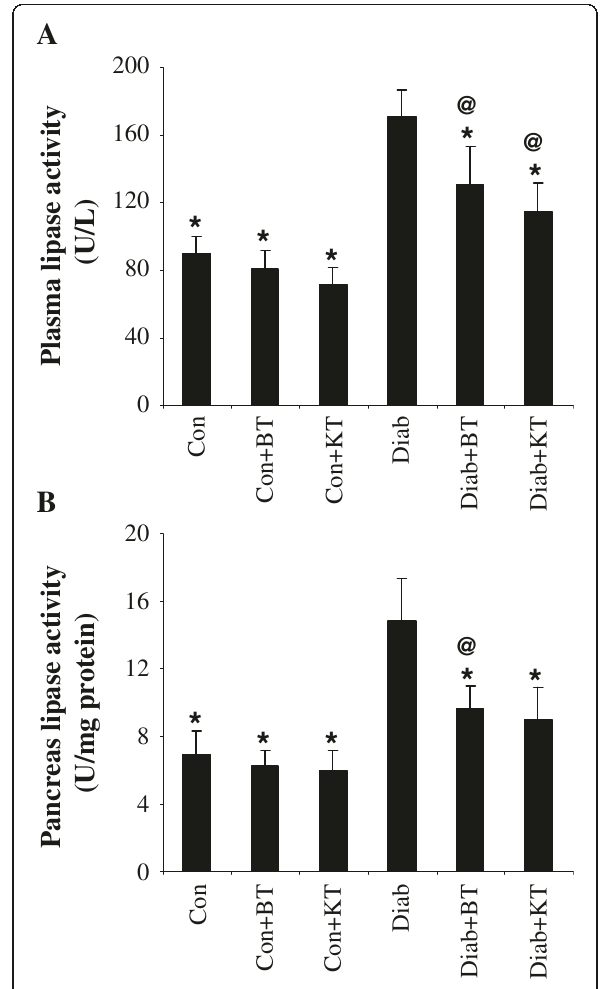
Figure 3 Effect of KT and BT on lipase activity in plasma (A) and pancreas (B) of surviving diabetic rats. Data represent mean±S.D (n=8 for each group). The values are statistically significant and presented as follows: single asterisk (*), p < 0.05 vs. control diabetic rats (Diab); commercial at (@), p < 0.05 vs. respective control rats (Con) [i.e. on the same corresponding tea treatment]; number sign (#), p < 0.05 vs. diabetic rats treated with BT